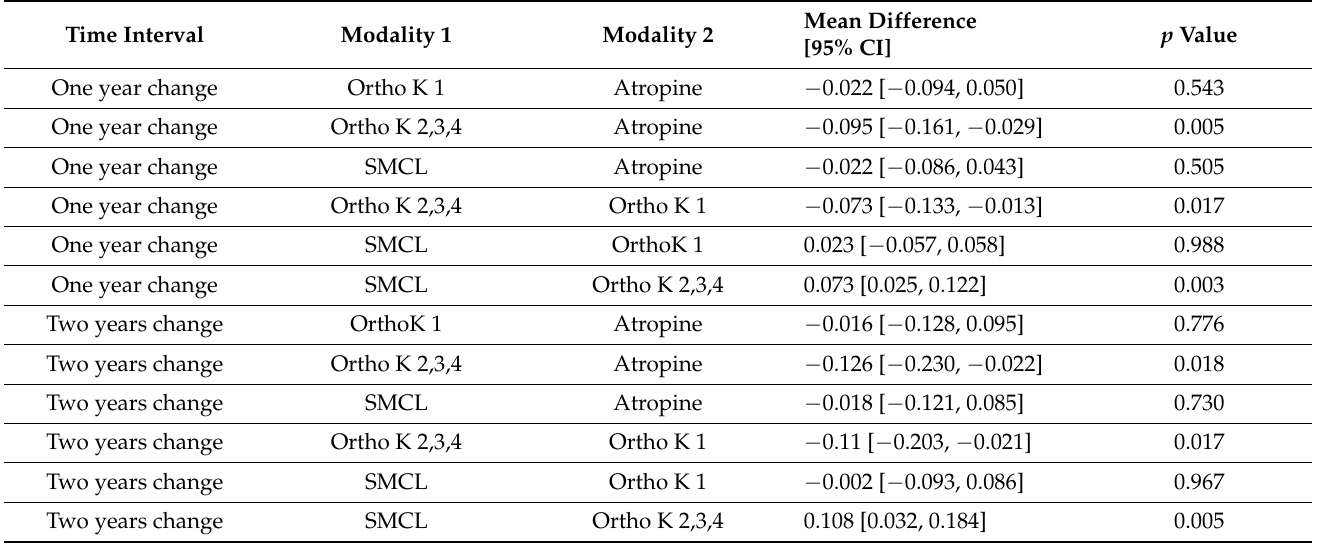
Table 8. Comparative efficacy of modalities used to manage axial length at 1 and 2